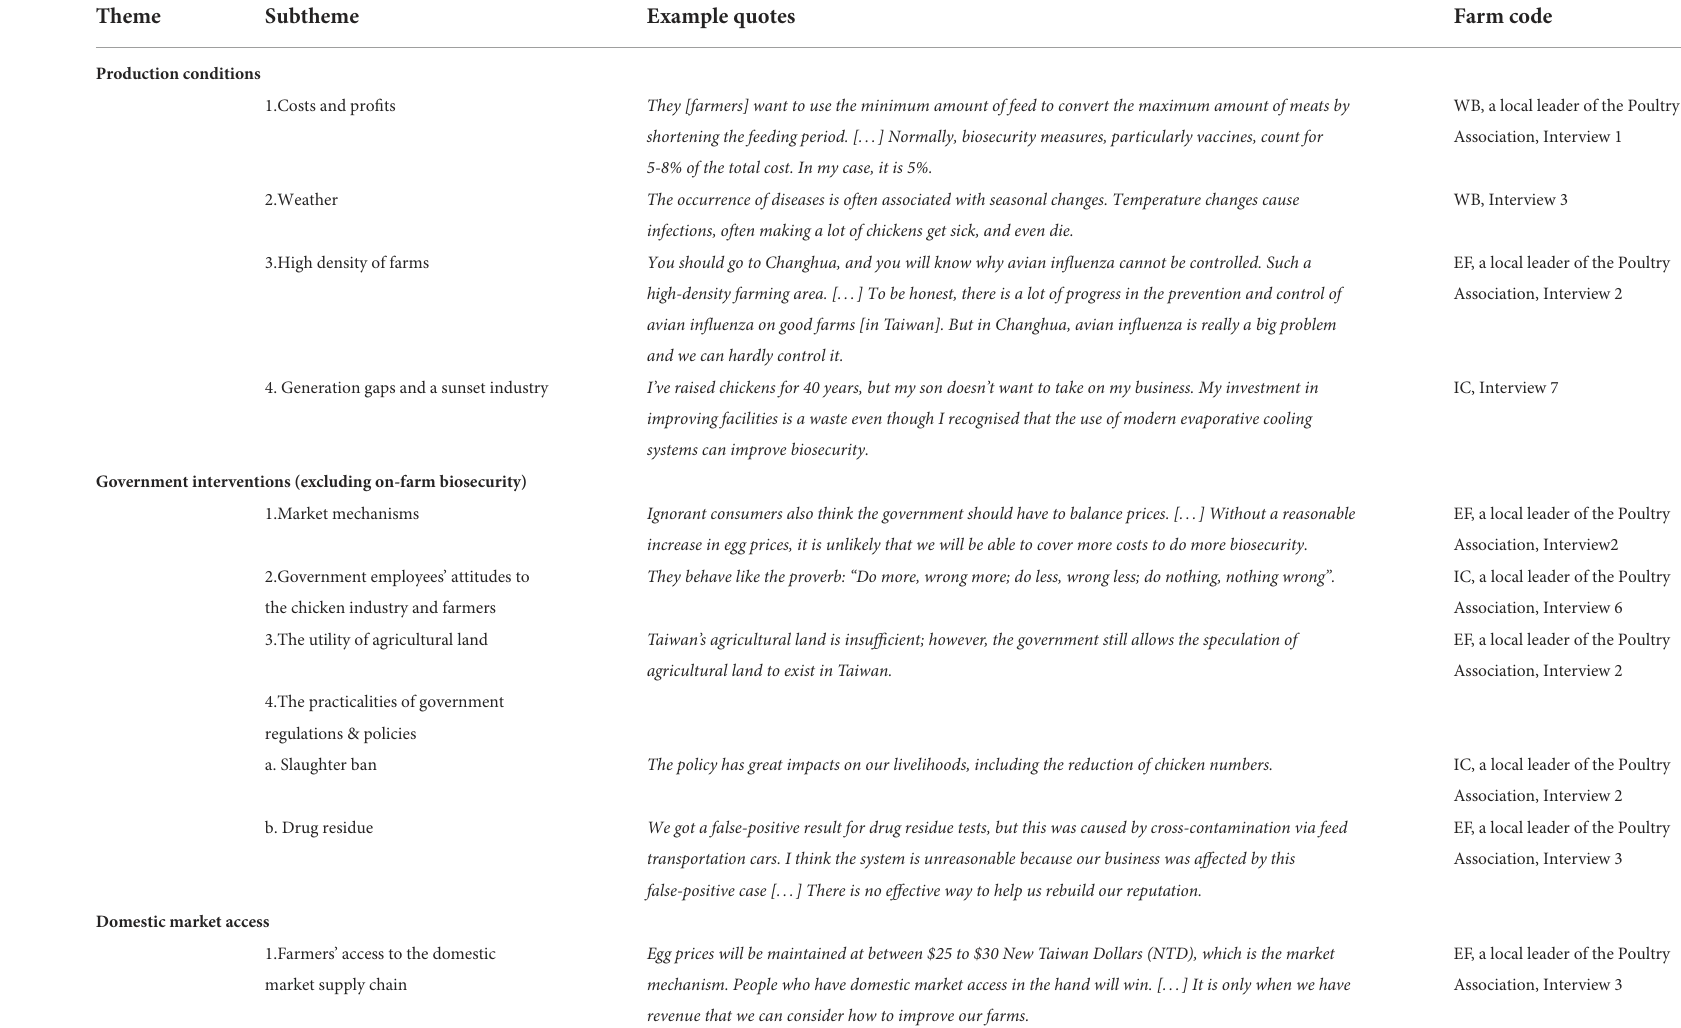
TABLE 3 Example quotes of themes and